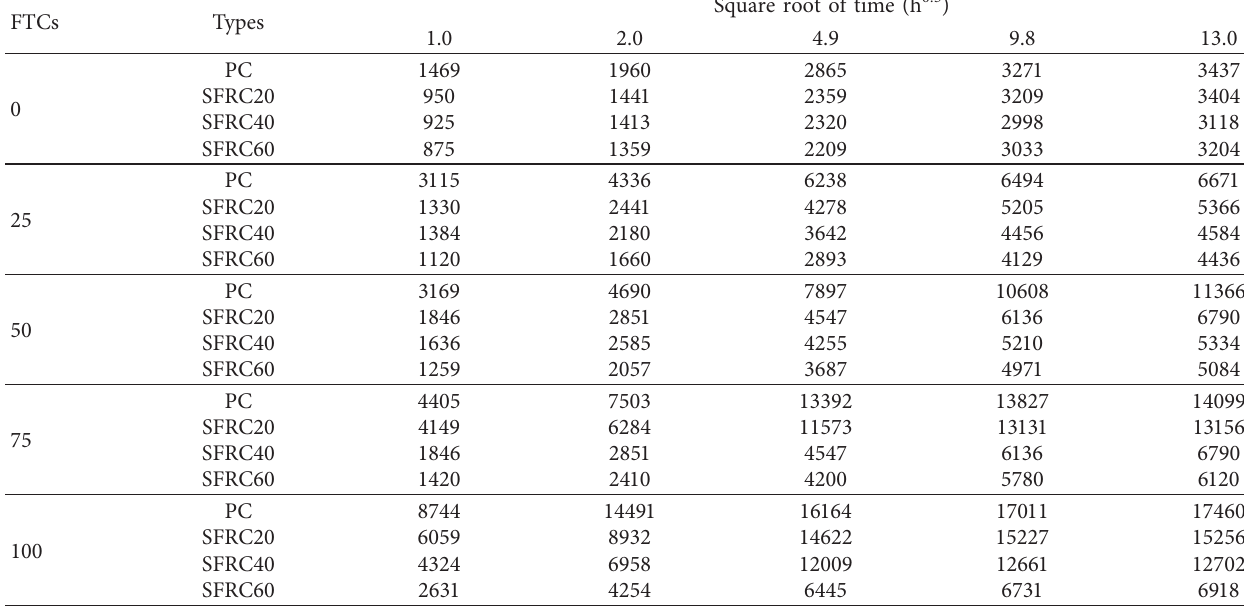
Table 6: Amount of absorbed water of the samples corresponding to different times.